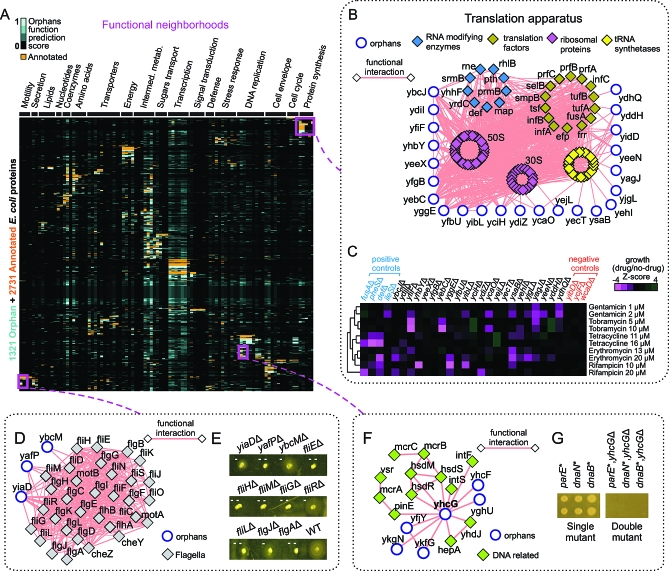
The Functional Neighborhoods of E. coli
(A) A “clustergram” displaying existing annotations (orange) and the orphan predicted functions (this study; blue) for all the protein-coding genes of E. coli (y-axis) and their associated biological processes (x-axis) (complete terms are provided in Figure S5 and Table S16). Proteins were clustered using MCL based on the paired similarity of the functional annotations and predictions in this matrix to delimit “functional neighborhoods” (see Table S17 for listing).(B) Putative functional neighborhood showing high-confidence integrated functional interactions (combined PI and GC networks) of select orphans with the protein synthesis machinery. For clarity, individual names of ribosomal proteins and tRNA synthetases are not shown.(C) Heat map showing the differential sensitivity of orphan deletion strains to antibiotics targeting protein synthesis relative to the colony size in the absence of drug (see Protocol S11 for details). Mutants deleted for annotated proteins from this neighborhood are shown as positive controls, whereas deletion mutants lacking genes not contained within this neighborhood are shown as negative controls.(D) Neighborhood with three orphans putatively involved in flagellum assembly and motility.(E) Deletions of the corresponding components reduce swarming capability; single dash (-), moderately impaired motility; double dash (- -), strong repression.(F) Subnetwork of orphans associated with DNA enzymes.(G) Deletion of the orphan yhcG results in synthetic lethality when combined with hypomorphic alleles (as indicated by an asterisk [*]) of three essential DNA replication factors (parE, dnaN, and dnaB).